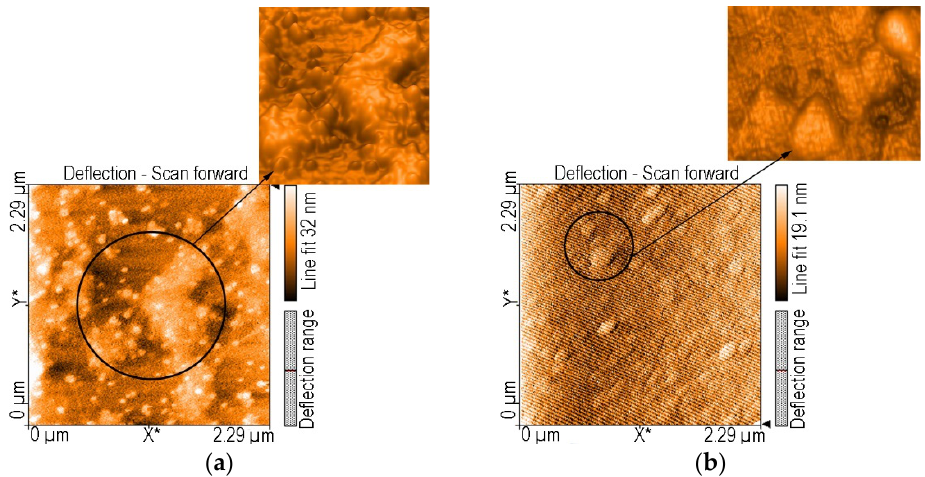
Figure 12. (5-COOH-3MPP)-k-carrageenan-AuNPs hybrid material deposited from DMF-water mixture ( a ); (5-COOH-3MPP)-k-carrageenan-AuNPs hybrid material after Mn 2+ detection, deposited from DMF-water mixture ( b ).